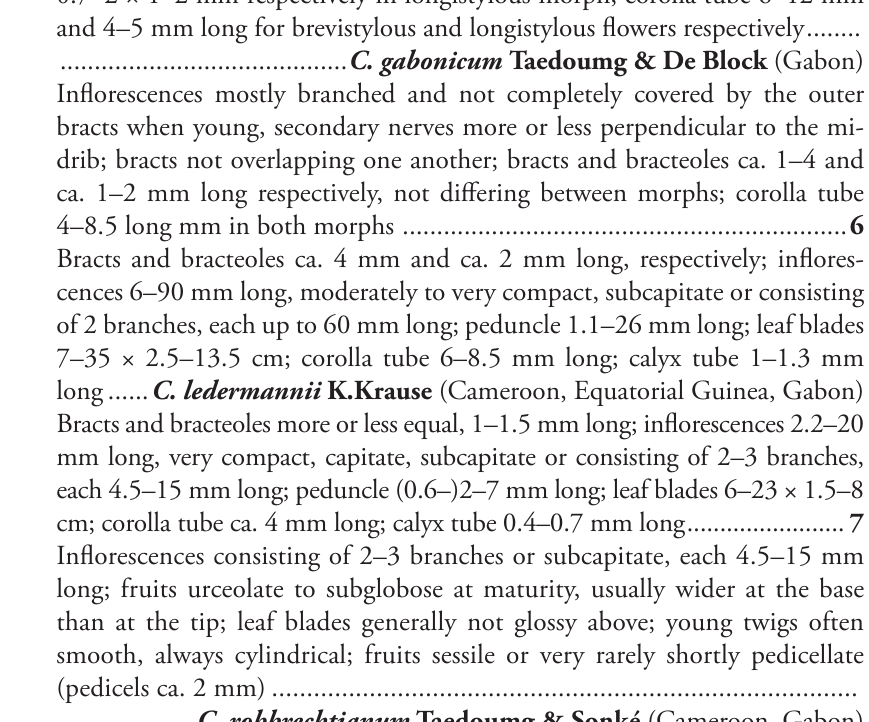
Bracts and bracteoles more or less equal, 1–1.5 mm long; inflorescences 2.2–20 mm long, very compact, capitate, subcapitate or consisting of 2–3 branches, each 4.5–15 mm long; peduncle (0.6–)2–7 mm long; leaf blades 6–23 × 1.5–8 cm; corolla tube ca. 4 mm long; calyx tube 0.4–0.7 mm long ........................ 7 7 Inflorescences consisting of 2–3 branches or subcapitate, each 4.5–15 mm long; fruits urceolate to subglobose at maturity, usually wider at the base than at the tip; leaf blades generally not glossy above; young twigs often smooth, always cylindrical; fruits sessile or very rarely shortly